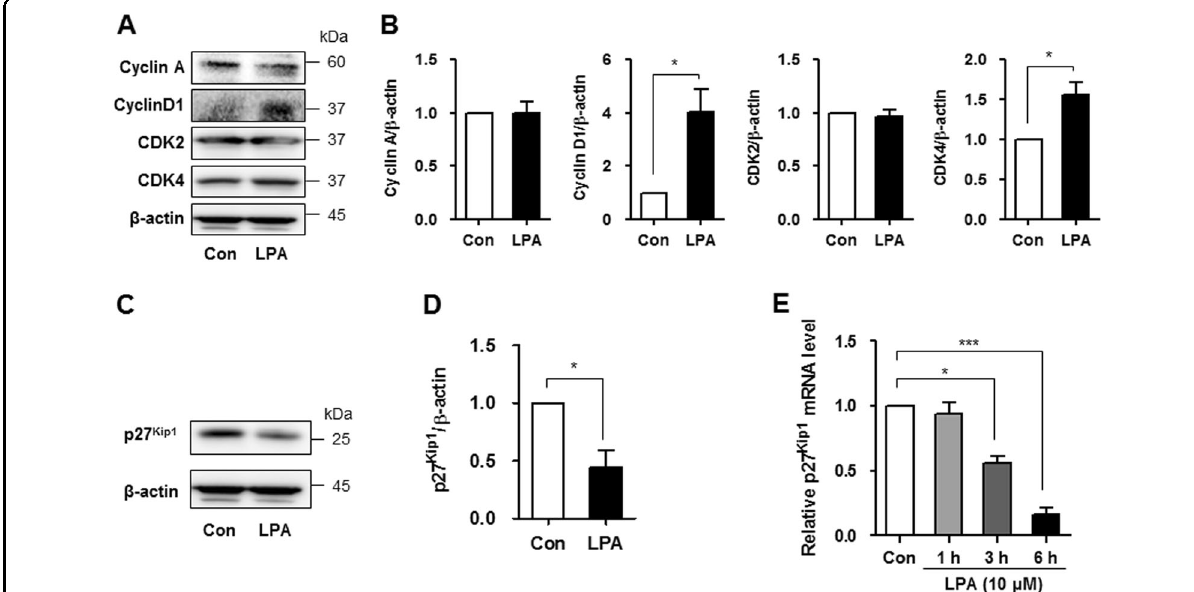
Fig. 2 LPA increases cyclin D1 and CDK4 expression by suppressing p27 Kip1 expression. SV40 MES13 cells were seeded in a six-well plate and starved in serum-free medium containing 0.1% fatty acid-free bovine serum albumin for 12 – 16 h. a Cells were treated with LPA (10 μ M) for 12 h, and the levels of the cyclin A, cyclin D1, CDK2, and CDK4 proteins were measured using western blot analyses ( n = 3 independent experiments). b The relative levels of the proteins were normalized to β -actin and quanti fi ed using ImageJ software. c Cells were treated with LPA (10 μ M) for 12 h, and the level of the p27 Kip1 protein was measured using western blotting ( n = 3 independent experiments). d The relative level of p27 Kip1 was normalized to β -actin and quanti fi ed using ImageJ software. e Cells were treated with LPA (10 μ M) for 1, 3, or 6 h, and the expression of the p27 Kip1 mRNA was analyzed using qRT-PCR ( n = 3 independent experiments). * p < 0.05, *** p < 0.001. Data are presented as means ±